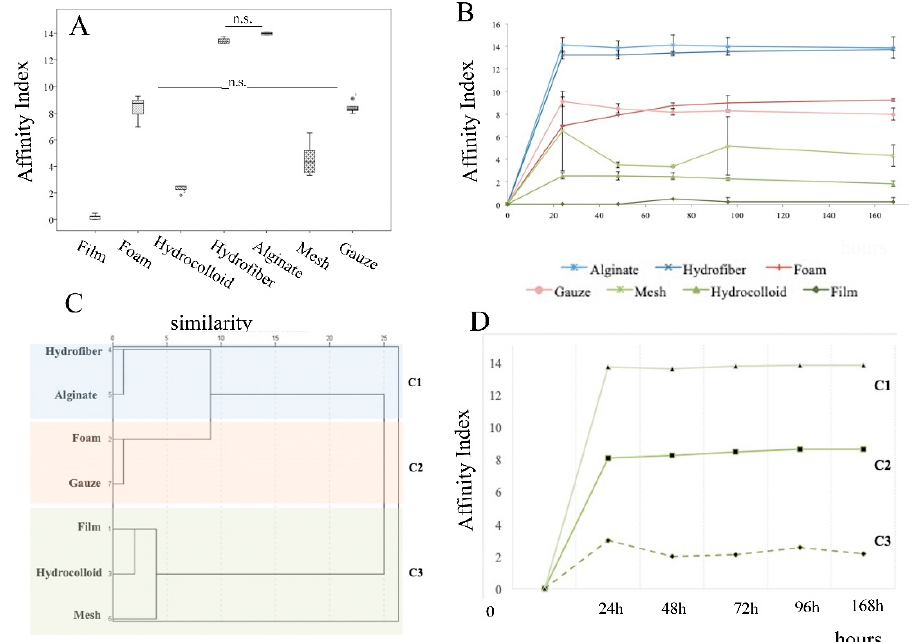
Figure 1. ( A ) The affinity index for PRF differed between dressings, p < 0.001 for all comparisons except “hydrofiber versus alginate”, and “foam versus gauze”, which were non-significant (n.s.) differences. Box plots depict the median, lower and upper quartile, symbols outside the box represent outliers; ( B ) Affinity index for PRF graft based on weight changes of the combination product, i.e., [PRF + dressing], over 7 days; ( C ) Dendogram showing the hierarchical relationship between dressings, the X axis is a measure of closeness of either individual dressings or clusters; cluster analyses reveal three groups of dressings, C1 (blue background) C2 (pink background), and C3 (blue background) ( D ) Cluster differences in the affinity index measured over 7 days.